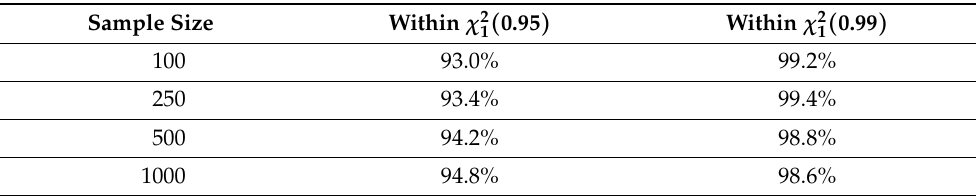
Table 2. Proportion of − 2log Λ values that lie within the χ 2 given various sample sizes, {100, 250, 500, 1000}.